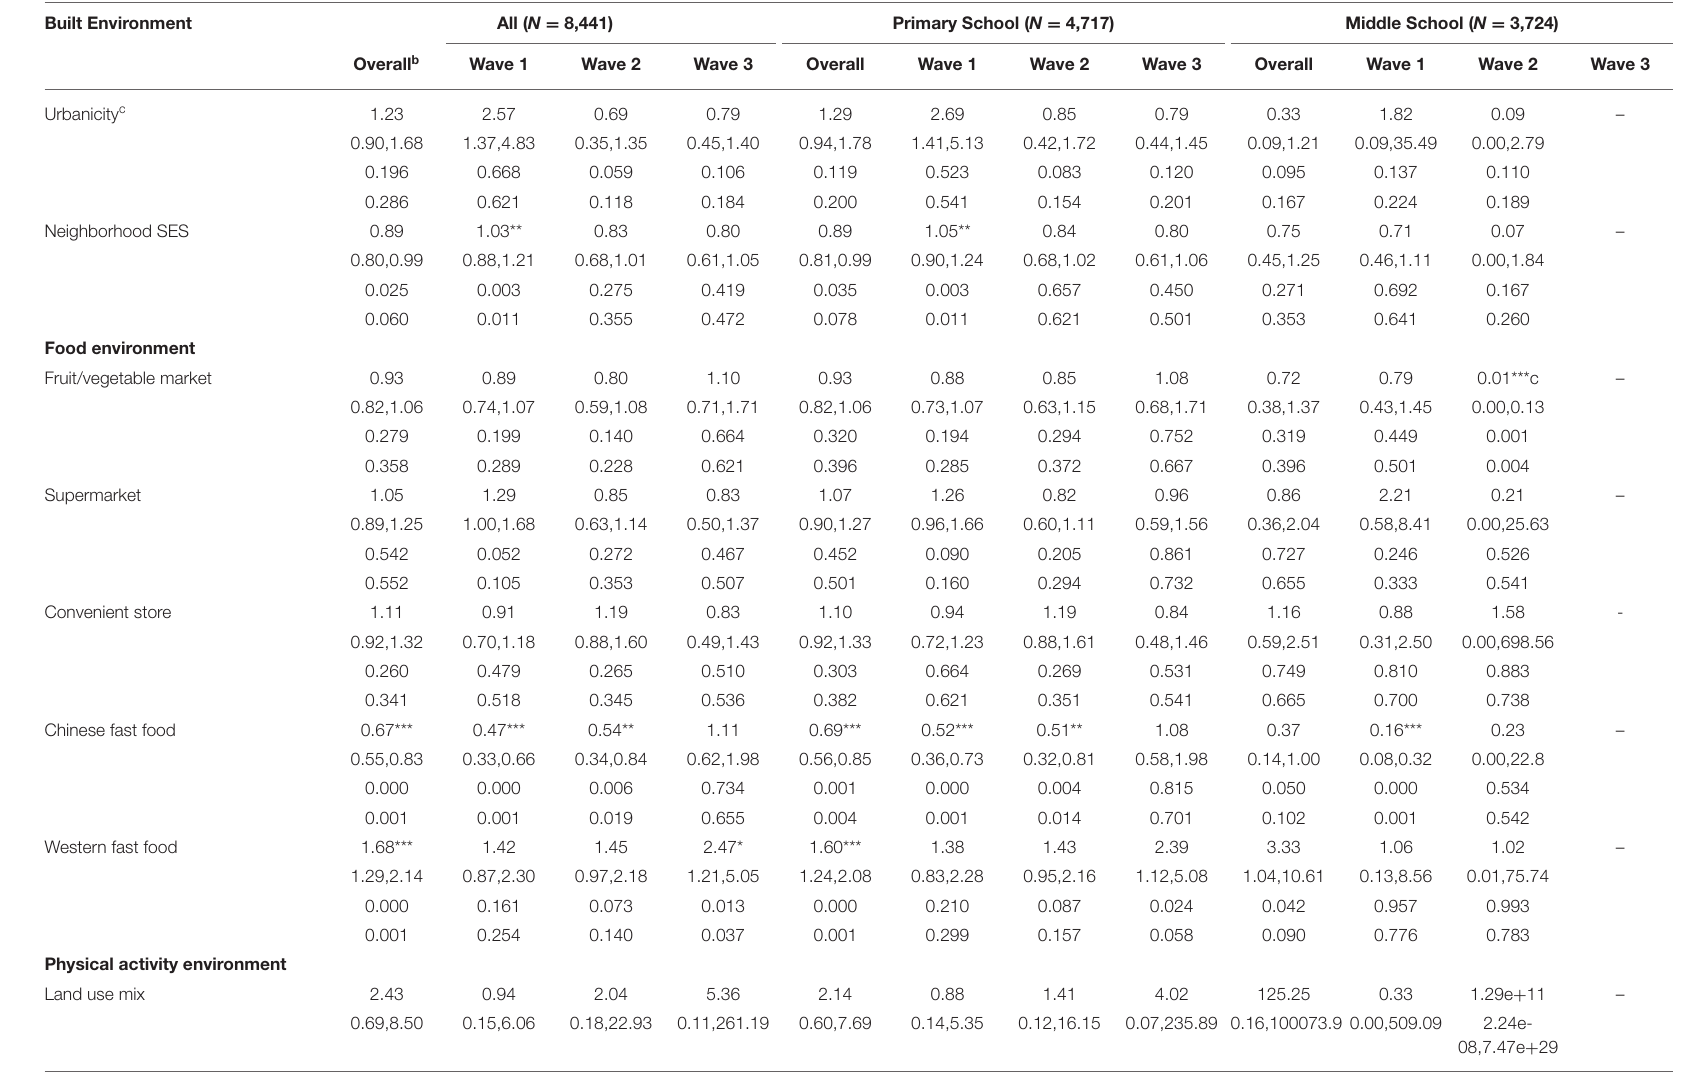
TABLE 4 | Associations of neighborhood built environments and childhood obesity 2011–2016 a